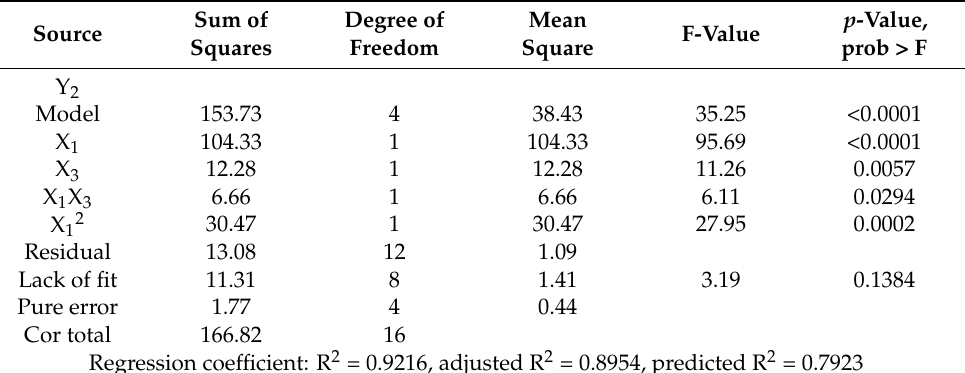
Table 5. ANOVA results of the fitted model for predicting Y 2